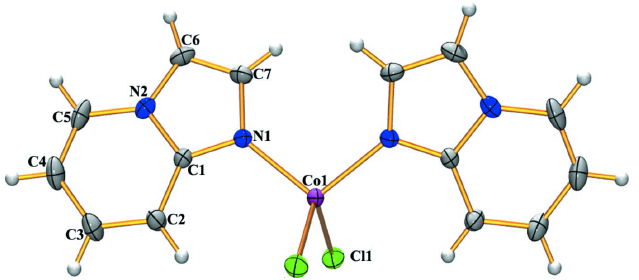
Figure 1 ORTEP view with atom-numbering scheme of the title complex with displacement ellipsoids drawn at the 30% probability level. The unlabeled counterpart is generated by the symmetry operation (cid:4) x + 1 y , (cid:4) z + 3 . 2